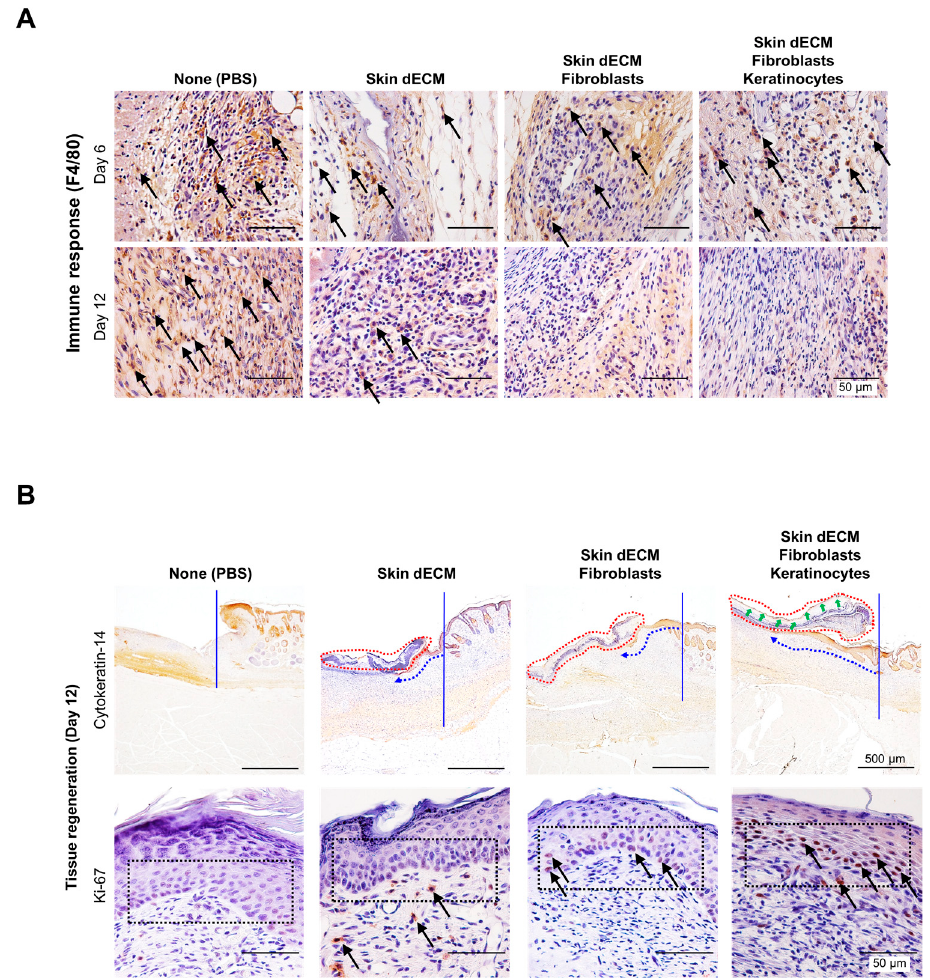
Figure 8. Histological analysis of the inflammatory process and re-epithelialization: ( A ) detection of F4/80 in macrophages within the tissue sections on days 6 and 12 (black arrows) of the inflammatory process; ( B ) detection of CK14 and Ki-67 expression to confirm re-epithelialization (blue arrows) and keratinocyte proliferation (black arrows), respectively.